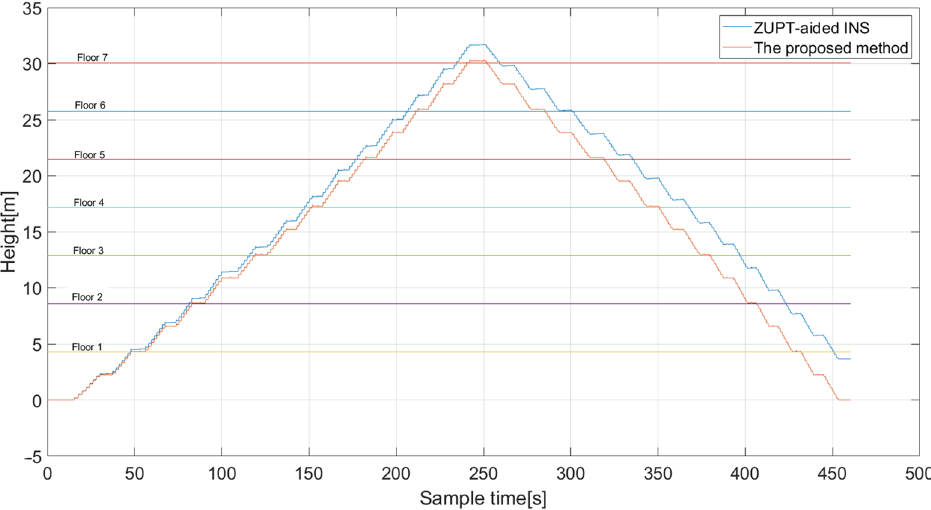
Figure 10. The altitude estimated by different methods.